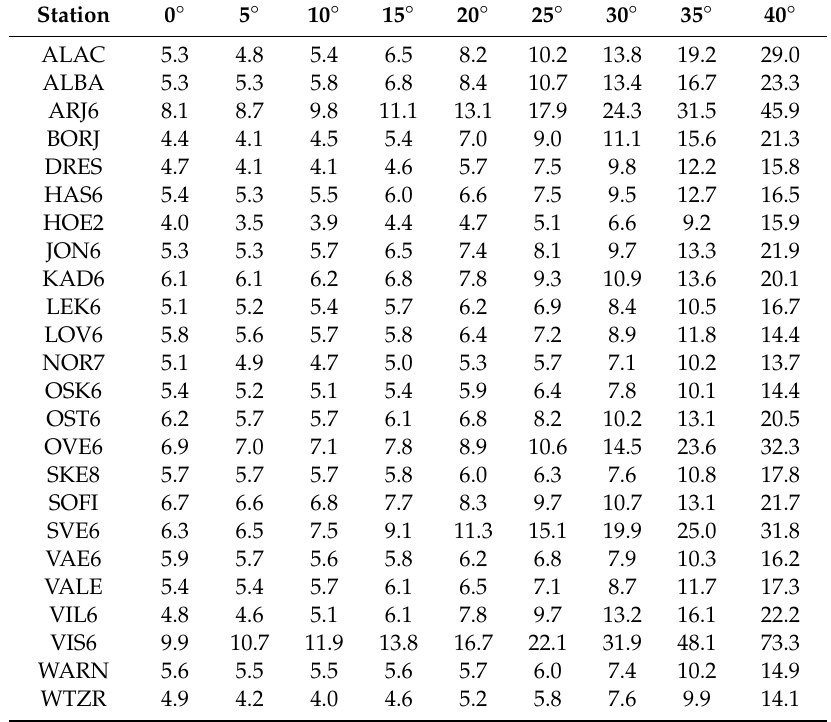
Table A4. Standard deviations of height for solutions based on type mean calibrations. Values are in millimeters.